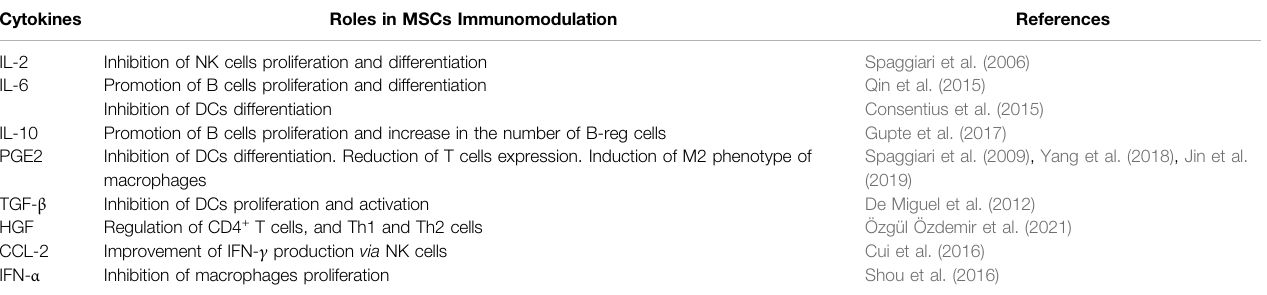
TABLE 1 | Summary of cytokines involved in immunomodulation of